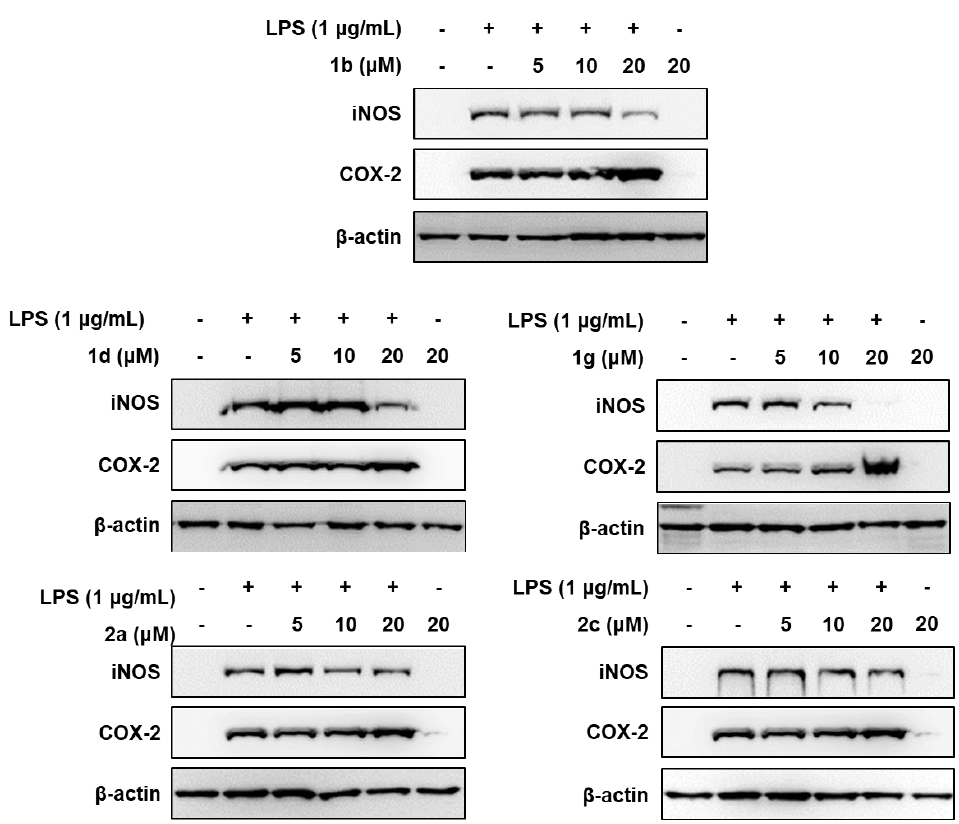
Figure 3. Inhibitory activity of compounds 1b , 1d , 1g , 2a , and 2c on inducible nitric oxide synthase (iNOS) and Cyclooxygenase 2 (COX-2) Cellular lysates were prepared from the with/without pretreatment tested compound (5, 10, and 20 μM) for one hour and then with LPS (1 μg/mL) for 24 h. Total cellular proteins were resolved by sodium dodecyl sulphate-polyacrylamide gel electrophoresis (SDS-PAGE), transferred to Polyvinylidene fluoride (PVDF) membranes, and detected with specific iNOS and COX-2 antibodies. β-actin was used as an internal control.